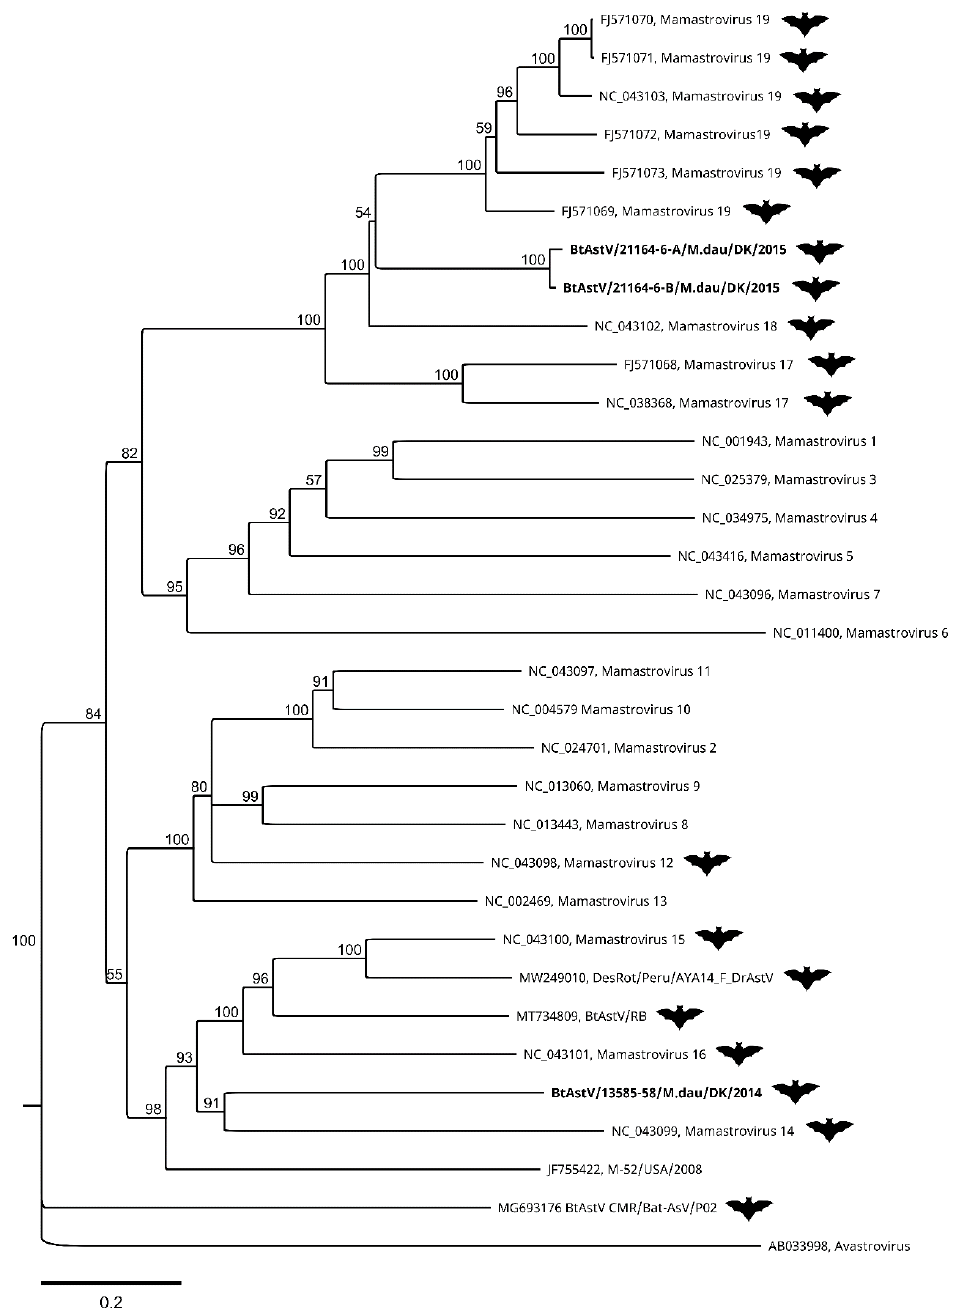
Figure 3. Phylogenetic tree of bat astrovirus sequences from Denmark. The Danish sequences (indicated in bold text) were analysed with the closest matching sequences with full ORF2 coding sequences available in GenBank, and at least one ICTV exemplar isolate of each species of the genus Mamastrovirus in the Astroviridae family, with an exemplar isolate of the genus Avastrovirus chosen as an outgroup. Bat astrovirus sequences are indicated with a bat symbol. The tree was generated using the neighbour-joining method, with 1000 bootstrap iterations on MUSCLE-aligned predicted amino acid sequences from the complete ORF2 gene coding sequence, with a total length of 1144 amino acids. Bootstrap values above 50 are